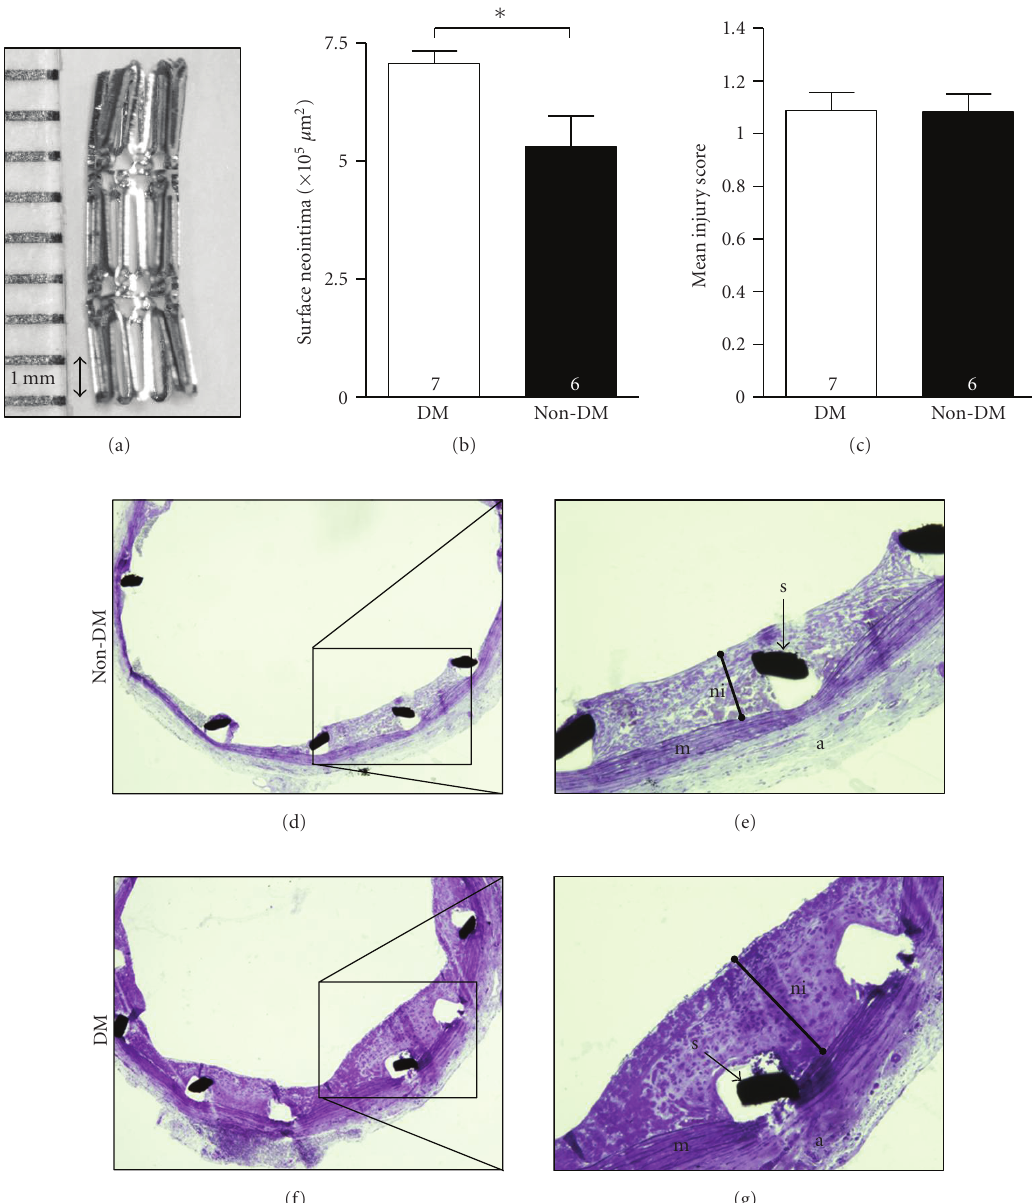
Figure 4: Long-term diabetes in BBDP rats is associated with enhanced in-stent restenosis 4 weeks after stenting in the abdominal aorta. (a) Photograph of a BeStent 2 bare metal stent used for implantation. The inflation balloon has been removed. (b) Surface area neointima present 28 days after stenting in long-term DM (white bar) and non-DM (black bar) BBDP rats. (c) Mean injury score at 28 days after stenting in long-term DM (white bar) and non-DM (black bar) BBDP rats. Data are expressed as the mean ± SEM ( ∗ P < . 05). Values within bars indicate the number of rats analyzed. DM: long-term diabetic BBDP rats, Non-DM: non-diabetic rats. ((d), (e)) Representative photomicrographs (Lawson staining) of stented abdominal aortas from a thymectomized non-diabetic (non-DM) BBDP rat 28 days after stenting. ((f), (g)) Representative photomicrographs (Lawson staining) of stented abdominal aortas from a diabetic (DM) BBDP rat 28 days after stenting. (e) and (g) are high-power magnifications (magnification × 100) of the framed areas shown in, respectively, (d) and (f) (magnification × 40). a: adventitia; m: media; ni: neointima; s: stent